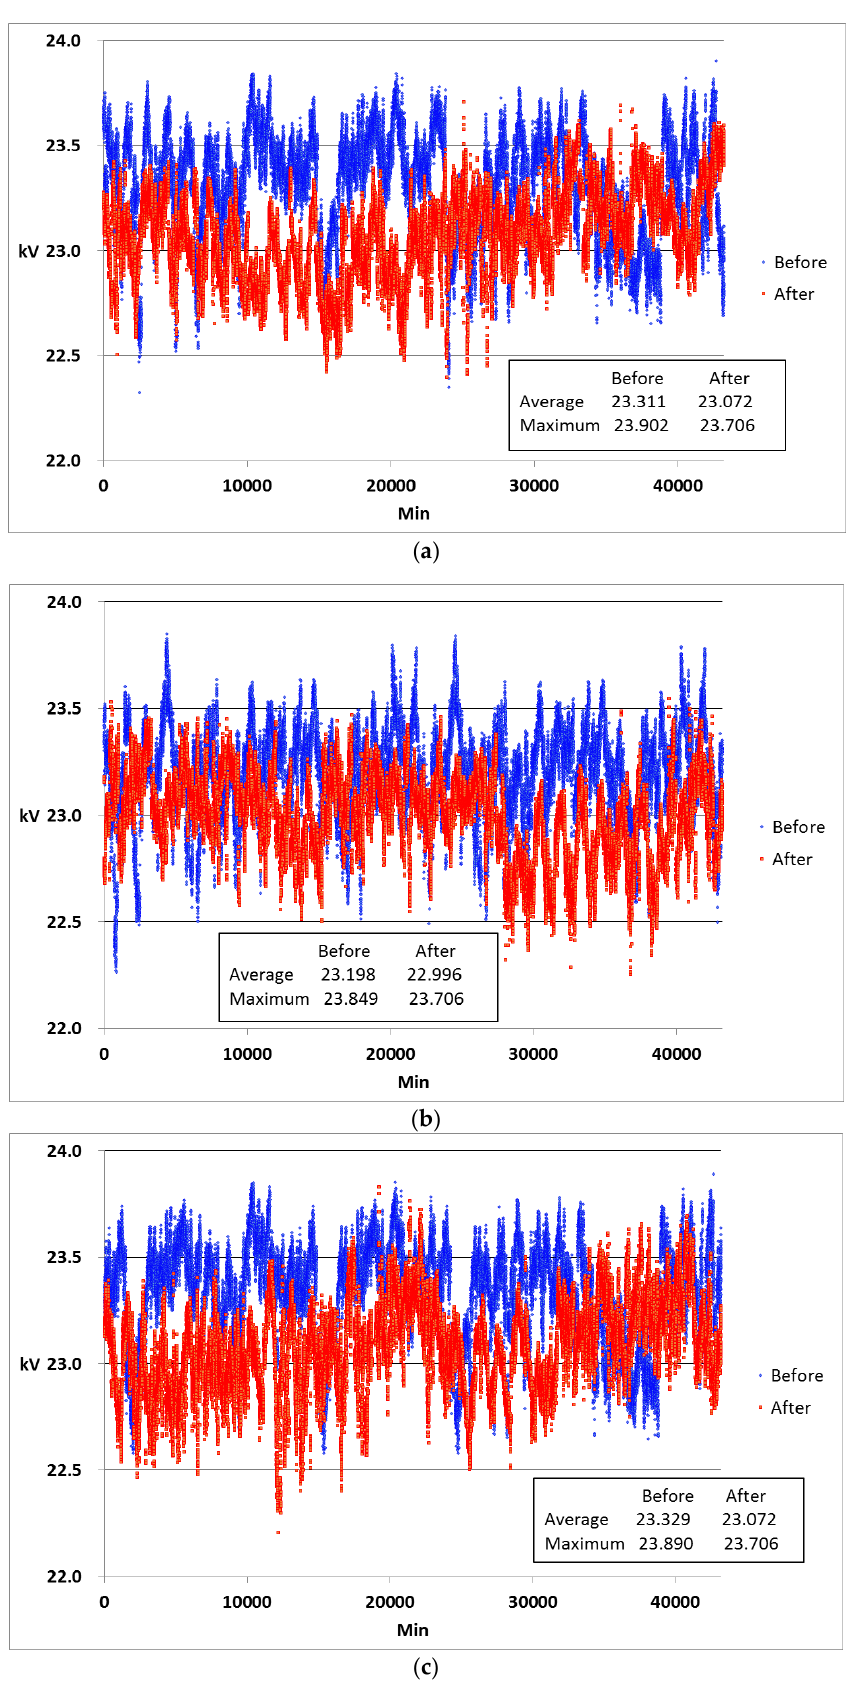
Figure 13. Comparison of monthly average grid voltage before and after installing the reactor. ( a ) first ( b ) second ( c ) third.